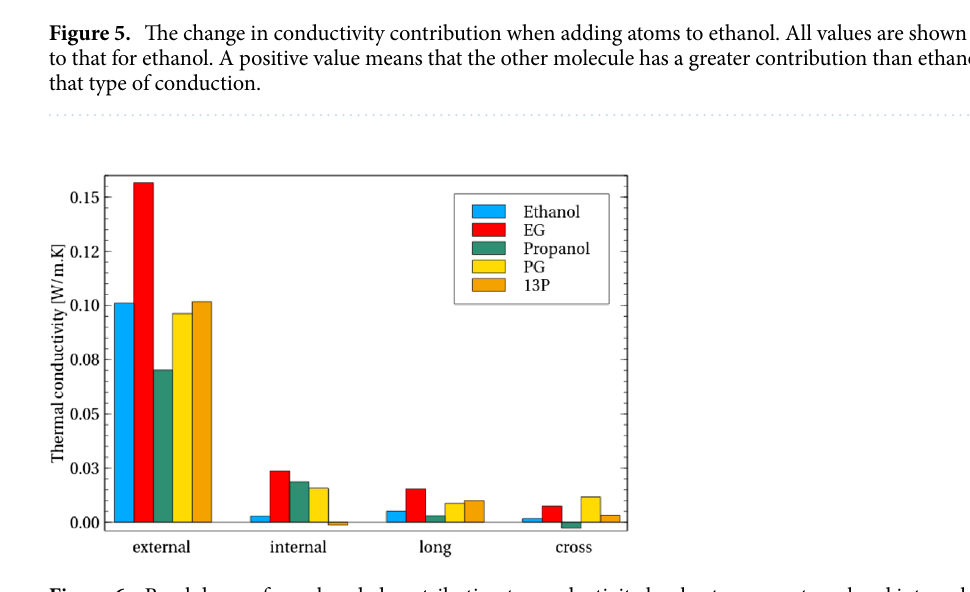
Figure 6. Breakdown of non-bonded contribution to conductivity by short-range external and internal non- bonded interaction, as well as long-range interactions and their